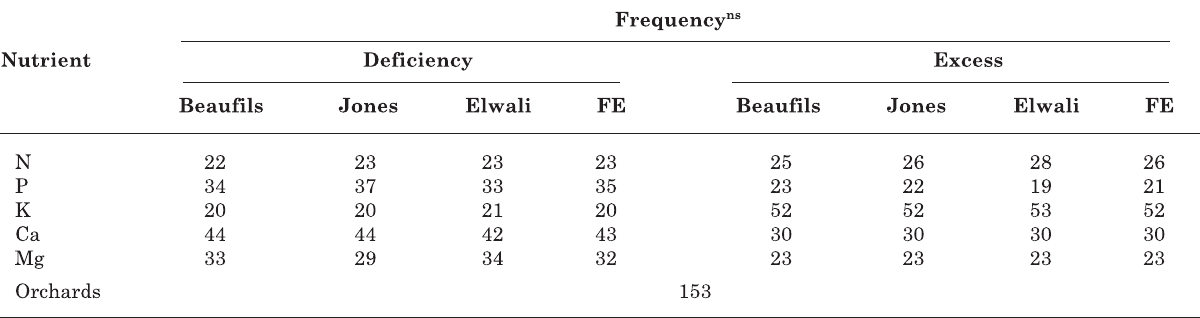
Table 2. Frequency of cupuaçu orchards with positive response potential (deficiency) and negative (excess)